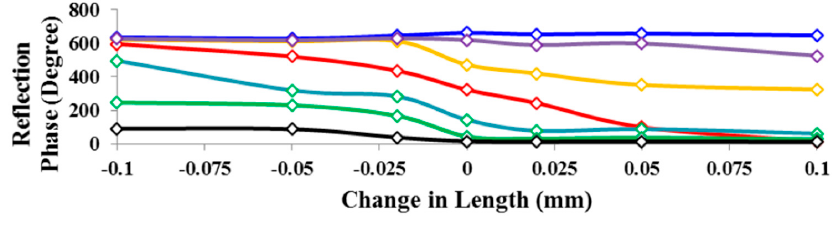
Figure 6. Simulated and measured reflection response of asymmetric patch element with: ( a ) Full ground; ( b ) Ground ring slot with r = 1 mm.